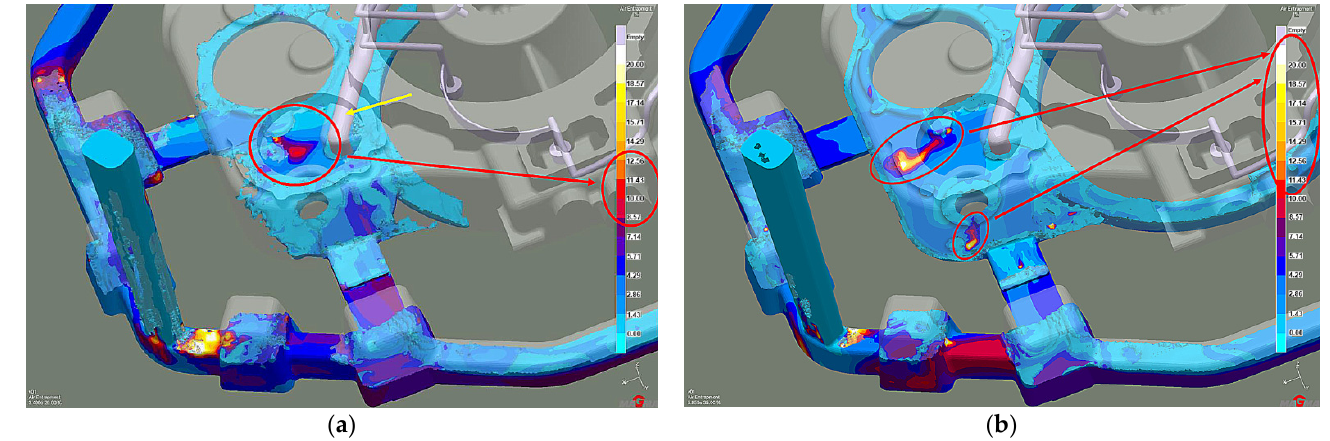
Figure 4. Stage 1 Liquid metal-air entrapment: ( a ) 20% of mold filling; ( b ) 35% of mold filling.